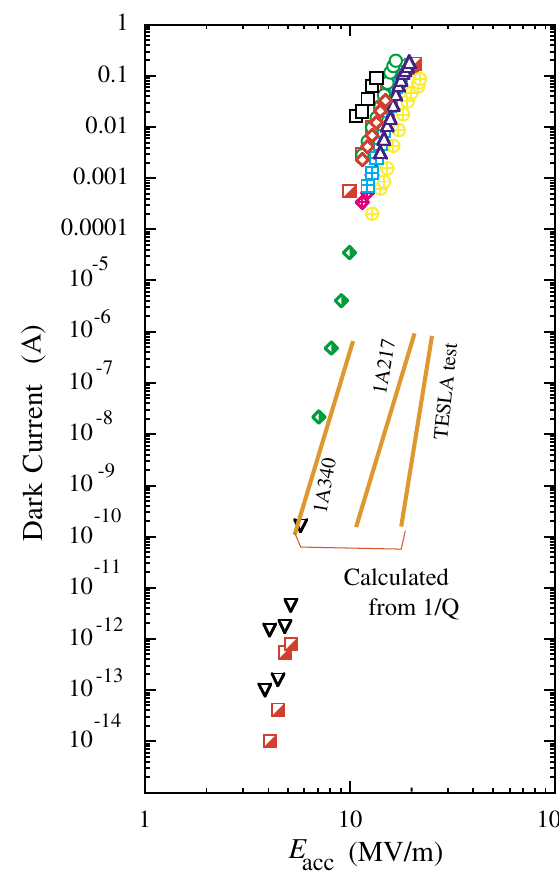
FIG. 27. (Color) SCRF dark currents compared with the 805 MHz cavity.